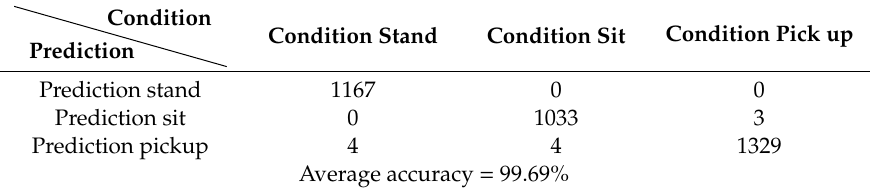
Figure 11. Test results obtained with the behavior-recognition model. Table 3. Confusion matrix of GRU-based